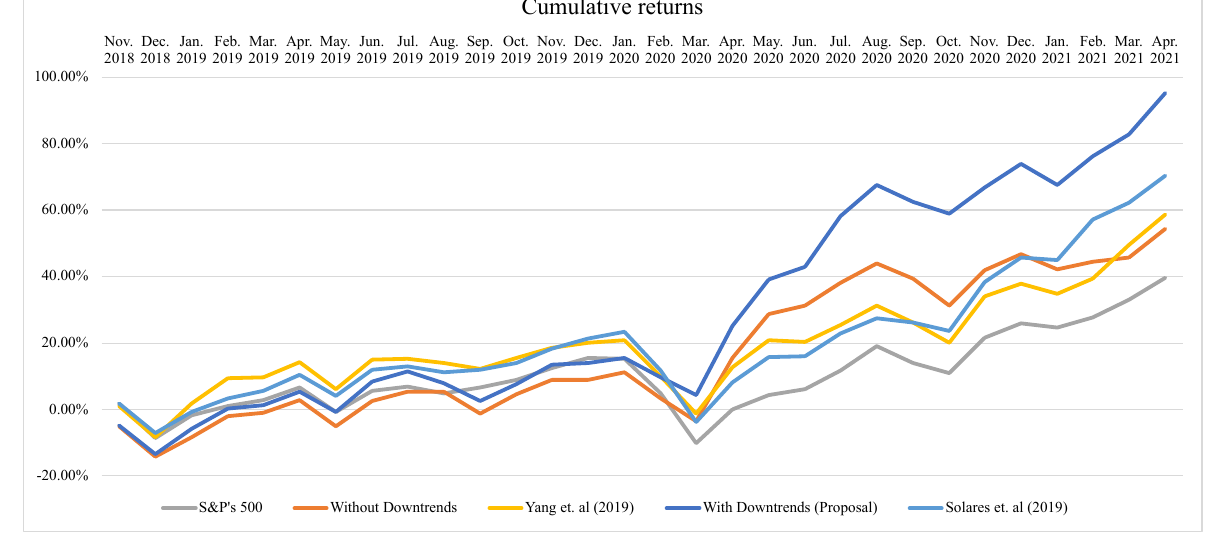
Figure 4. Cumulative returns